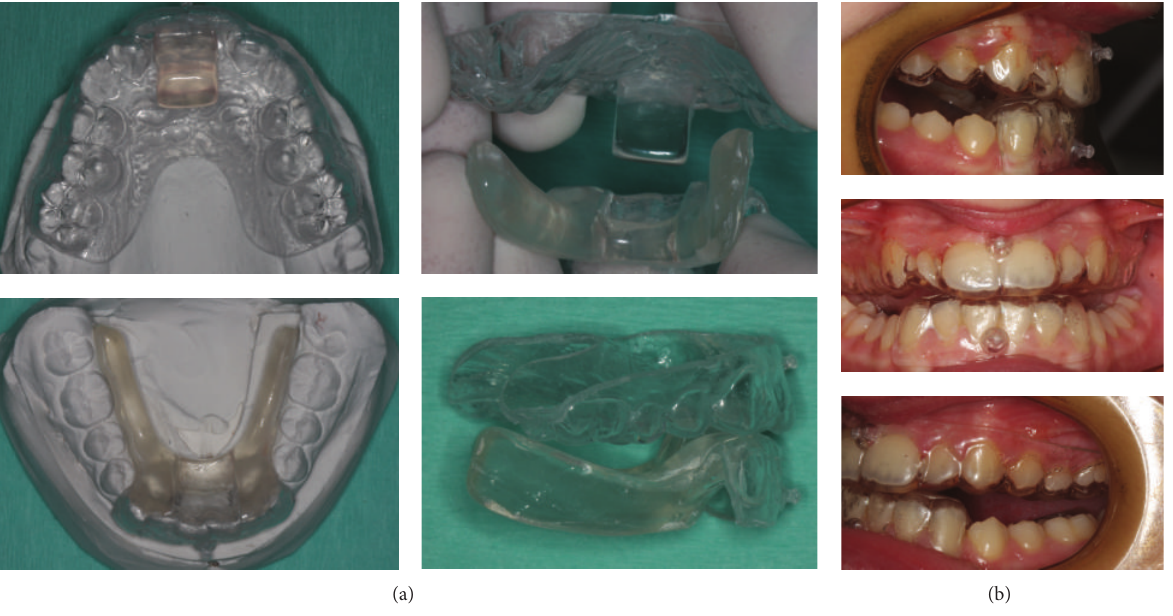
Figure 3: (a) Extraoral and (b) intraoral views of the HAF appliance used in this treatment.